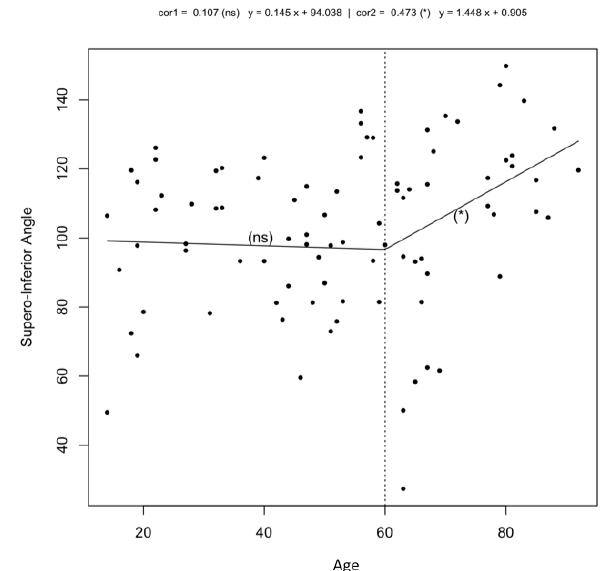
Figure 1. Position of landmark M (medial) on the inferior turbinate using AMIRA.